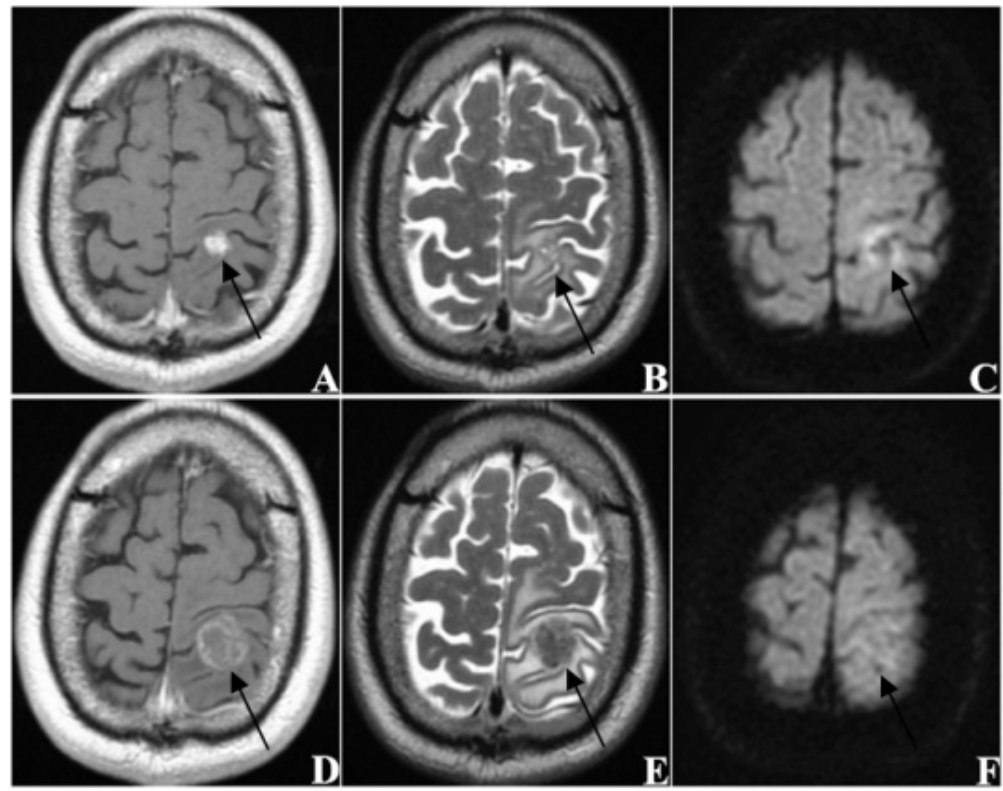
Figure 5. A sixty-year-old male patient (KPS = 70) with brain metastases (n = 1) from lung cancer. The primary tumor recurred after surgery with mediastinal lymph node metastasis. ( A – C ) re MRI images taken before SRS treatment, and ( D – F ) are MRI images taken at follow-up 60 days after treatment ( A , D from CE-T1WI; B , E from T2WI; C , F from DWI). The tumor was located in the left frontoparietal junction and showed homogeneous enhancement. The EI was 4.38. After treatment, the tumor was obviously enlarged and the edema was aggravated, thus this patient was classified as PD.